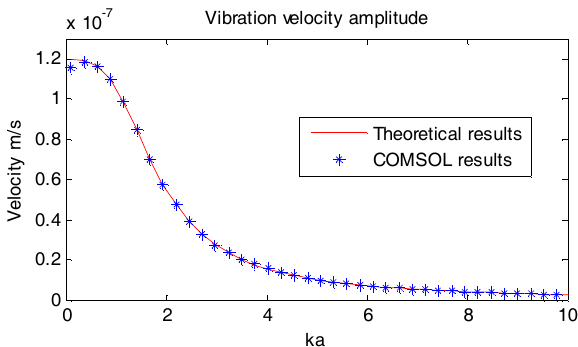
Figure 9. Vibration velocity amplitude of the OBS in free field.